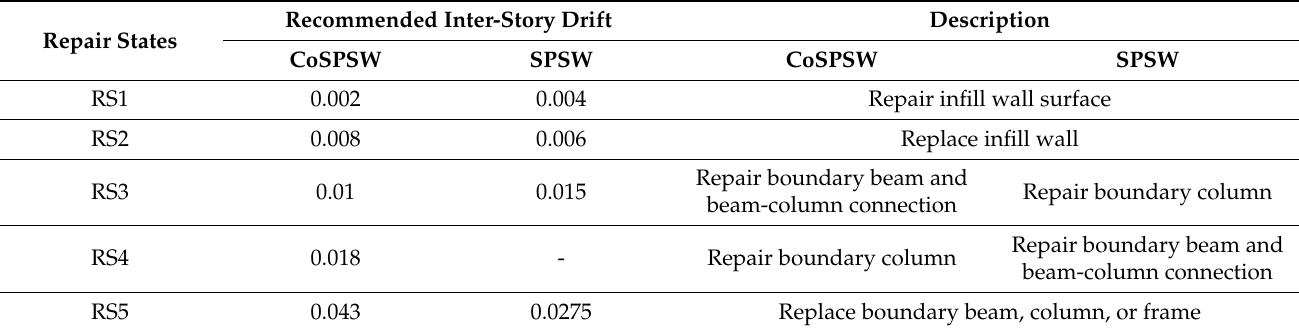
Table 7. Repair states and recommended inter-story drift of CoSPSWs and